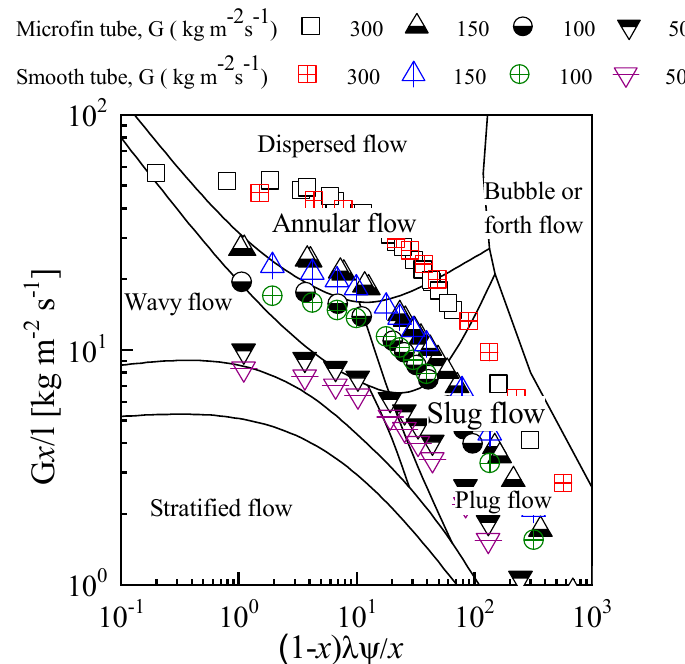
Figure 9. Flow pattern prediction by Scott flow pattern map [28].